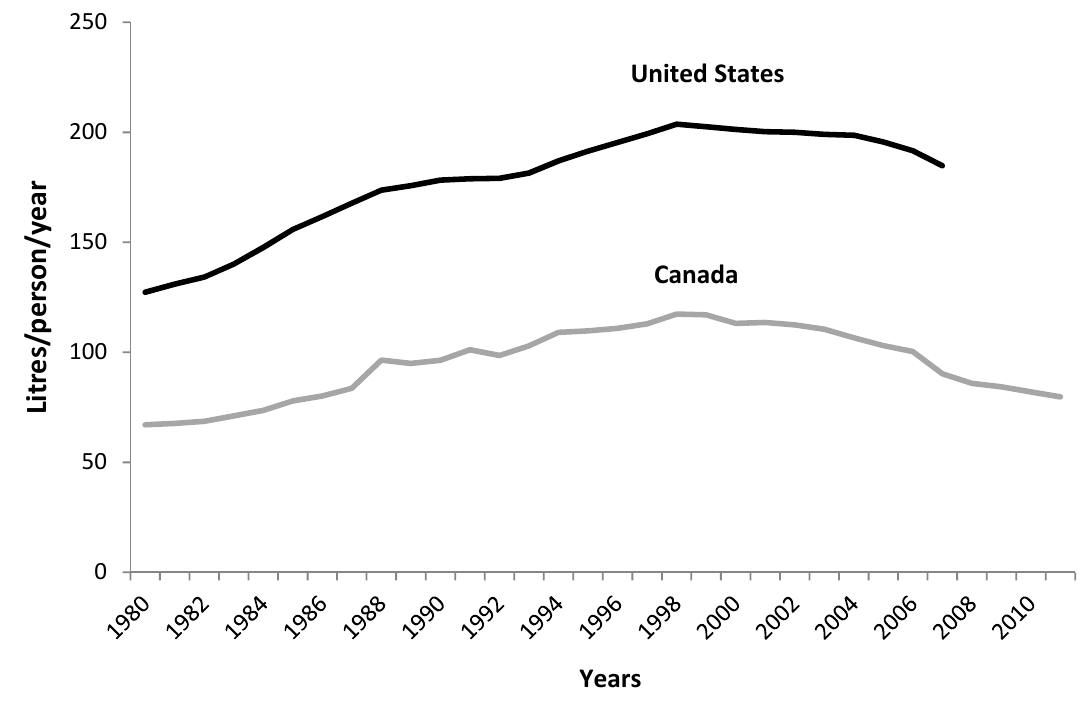
Figure 3. Soft drinks available for consumption (unadjusted) per capita from 1980 to 2011 in Canada and the United States. Canadian soft drink availability data includes both caloric and non-caloric soft drinks. For comparison, US data also includes both caloric and non-caloric soft drinks. Canadian diet drink share is not available; however, US share was 31% in 2007. Sources: Statistics Canada (2012) and United States Department of